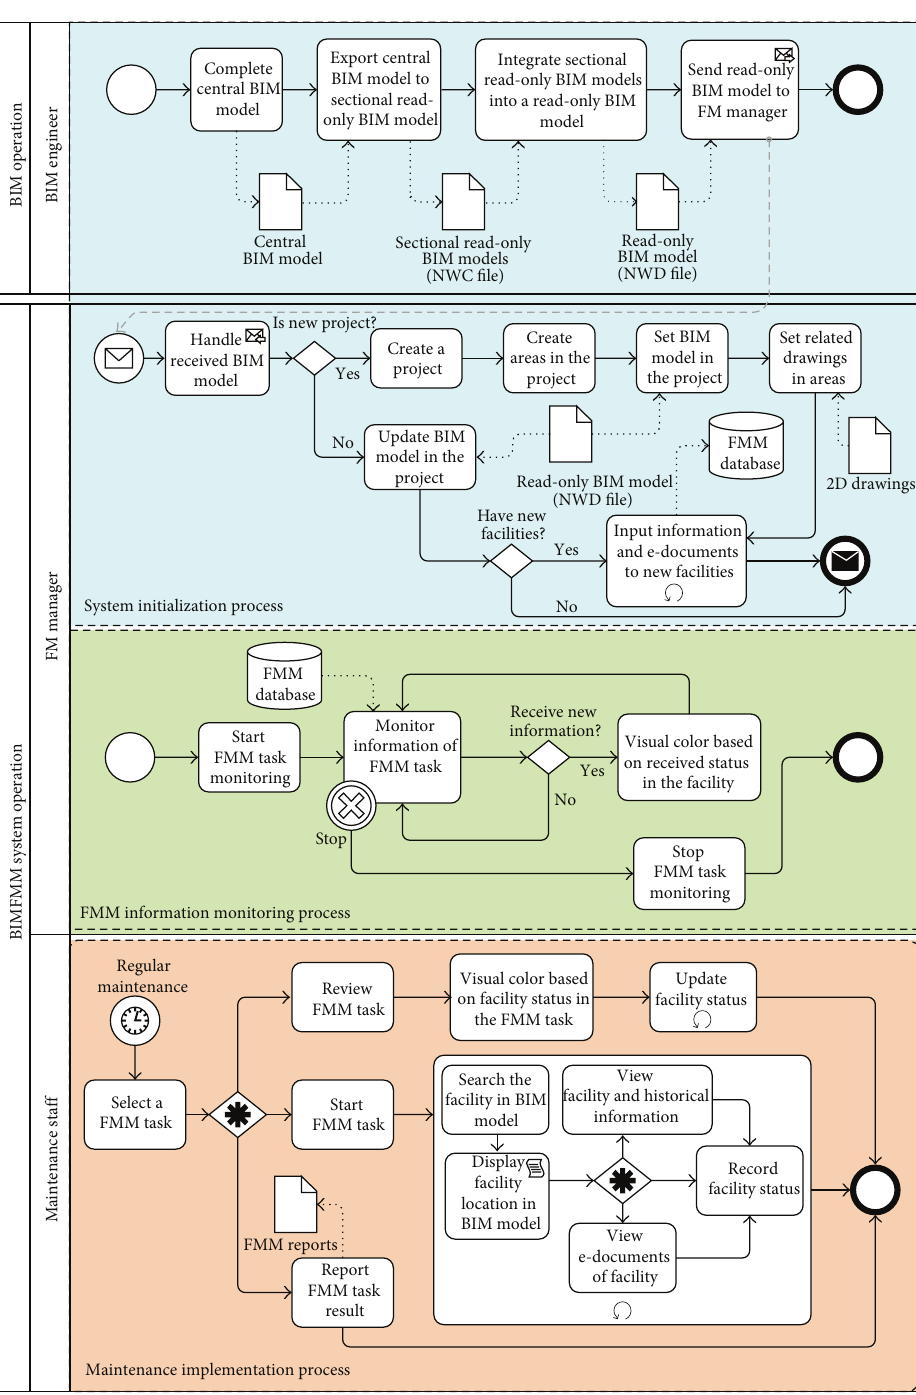
Figure 4: The process diagram used in the BIMFMM